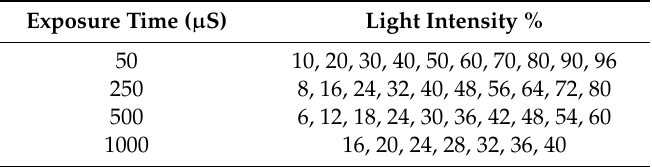
Table 2. The design of the experiment investigating the sensor linearity. Light intensity is given as a percentage of the integrating sphere source maximum light intensity. The maximum power of the source is 1 mA. Only the first 7 levels of light intensity were used in the 1000 µ S experiment to avoid the image